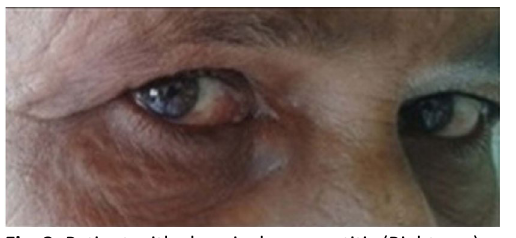
Fig. 3. Patient with chronic dacryocystitis (Right eye) Fig. 4. Patient with lacrimal Table 6. Antibiotic sensitivity pattern of Gram-negative bacilli (n=16)